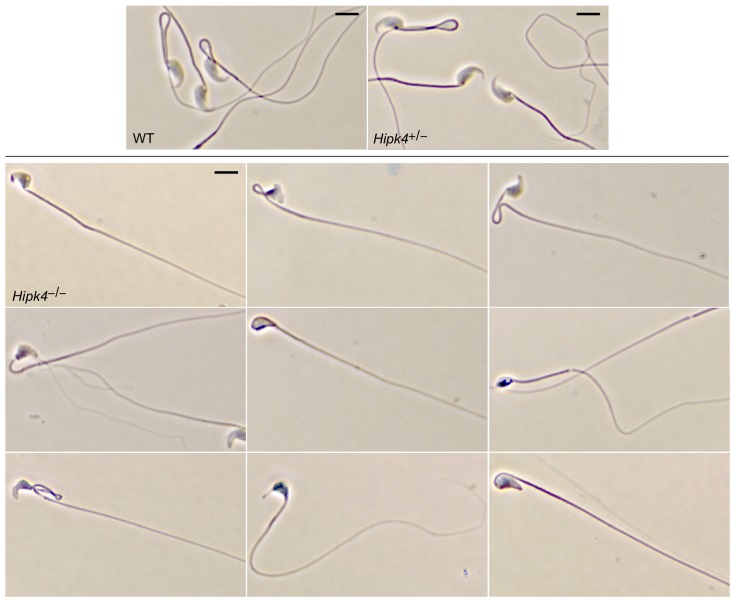
Morphologies of wild-type and Hipk4 mutant sperm.Phase contrast images of sperm obtained from mice with the designated genotypes. Sperm were treated with Diff-Quik stain prior to imaging, and multiple examples of homozygous mutant sperm are shown to illustrate the range of morphological phenotypes. Scale bars: 2 µm.